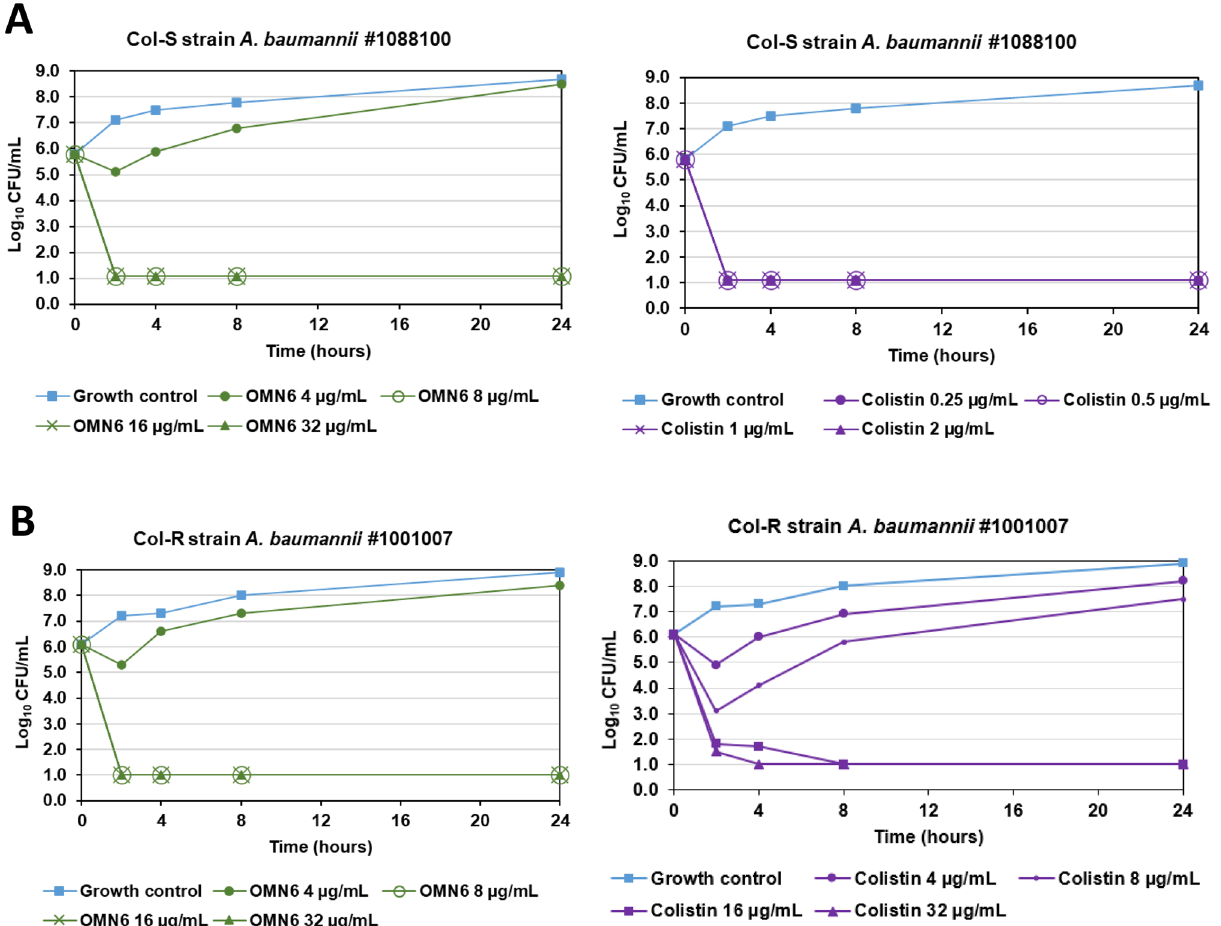
Figure 3. Fast bactericidal effect of OMN6 on colistin-sensitive and colistin-resistant A. baumannii strains. ( A ) Comparison of OMN6 (left) and colistin (right) killing kinetics on colistin-sensitive A. baumannii JMI #1088100 strain. ( B ) Comparison of OMN6 (left) and colistin (right) killing kinetics on colistin-resistant A. baumannii JMI #1001007 strain. Quantity of bacteria is displayed in log 10